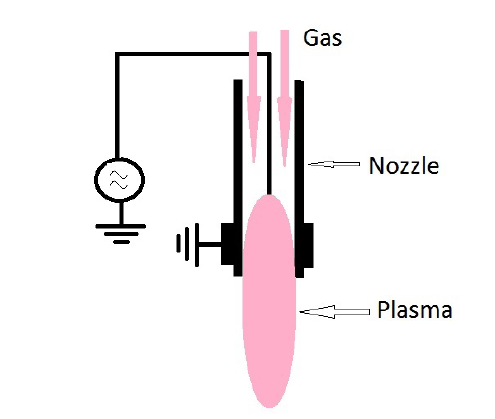
Figure 1: Atmospheric pressure plasma jet (APPJ; INP Greifswald, Germany) - schematic set-up.